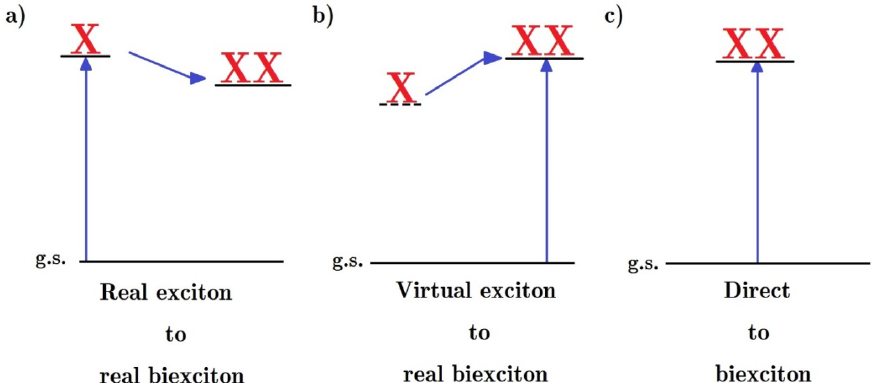
Figure 5. Models of biexciton formation from a single absorbed photon: ( a ) a photo-generated hot exciton relaxes by impact ionization, exciting another electron across the band gap; thereby creating a biexciton ( b ) the direct photogeneration of a biexciton through a virtual exciton or biexciton states [62]; and ( c ) the photo-generation, by a single photon, of a quantum superposition of all possible excited states, including